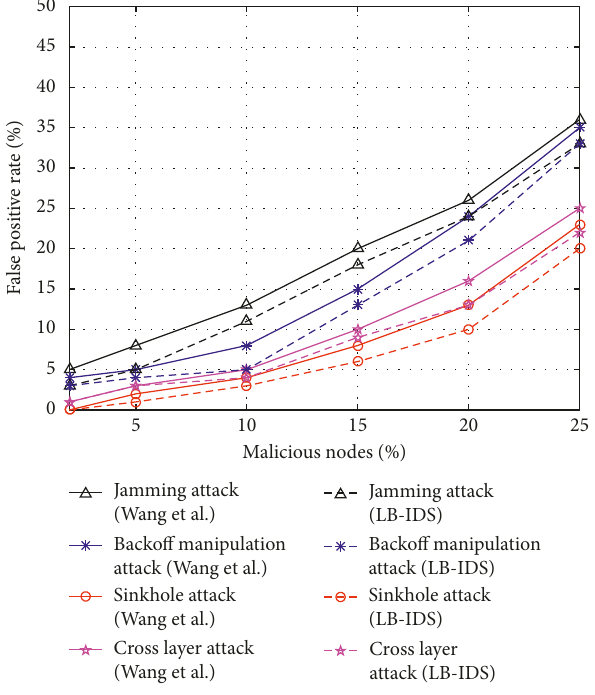
Figure 11: FPR comparison between LB-IDS and Wang et al. scheme [1]. Table 4: Average of false-positive